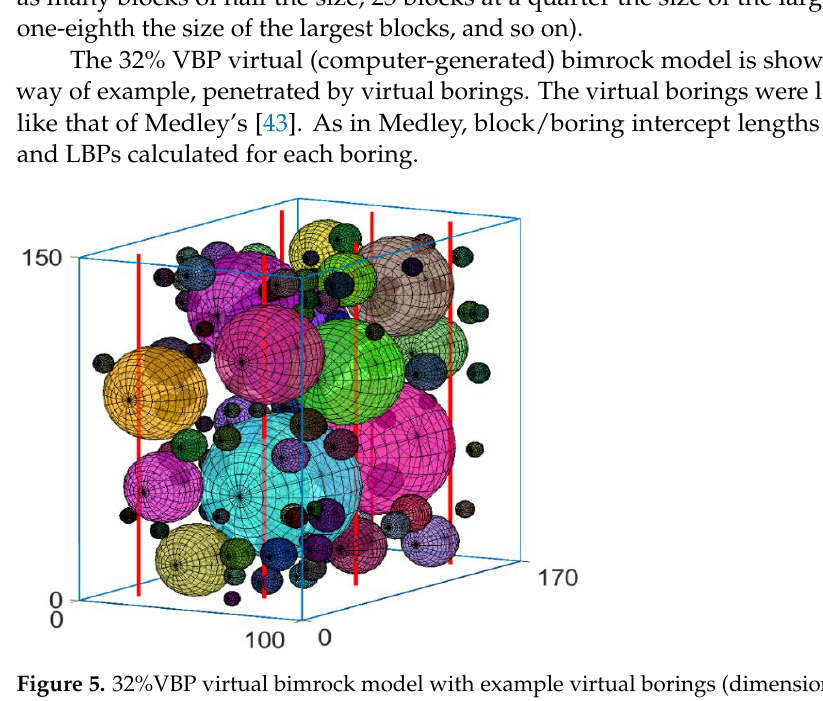
Figure 5. 32%VBP virtual bimrock model with example virtual borings (dimensions in millimeters).